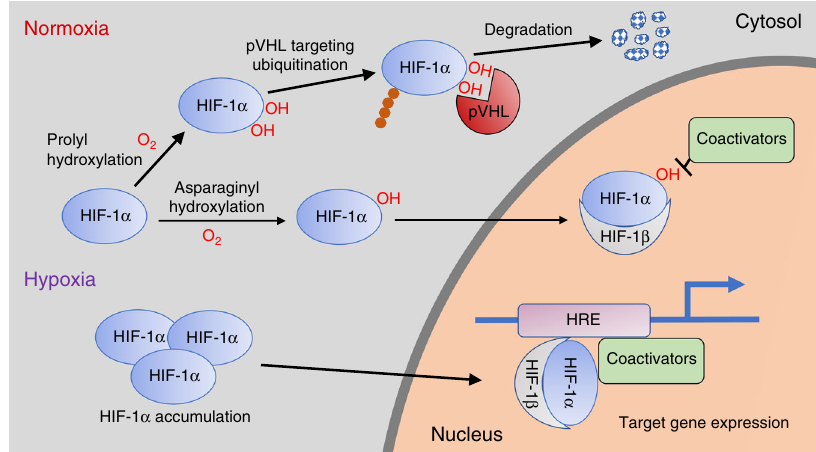
Fig. 1 Scheme of the O 2 -sensitive HIF – PHD – pVHL signaling pathway. See